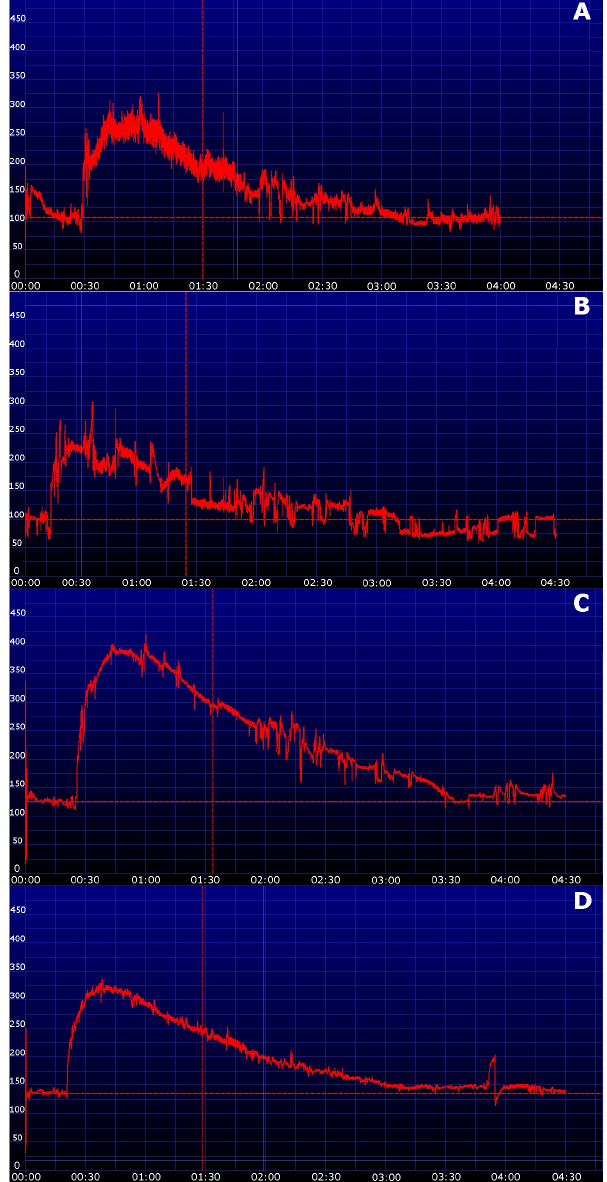
Figure 2. Transcutaneous disappearance curves of fluorescein-isothiocyanate-labelled sinistrin in a dog with the device placed on the four different locations (A – hindlimb, B – forelimb, C – ventral abdomen, D – lateral thorax). The x-axis represents time, the y-axis represents the relative transcutaneous fluorescence. Note that there are minimal artifacts in curve D.